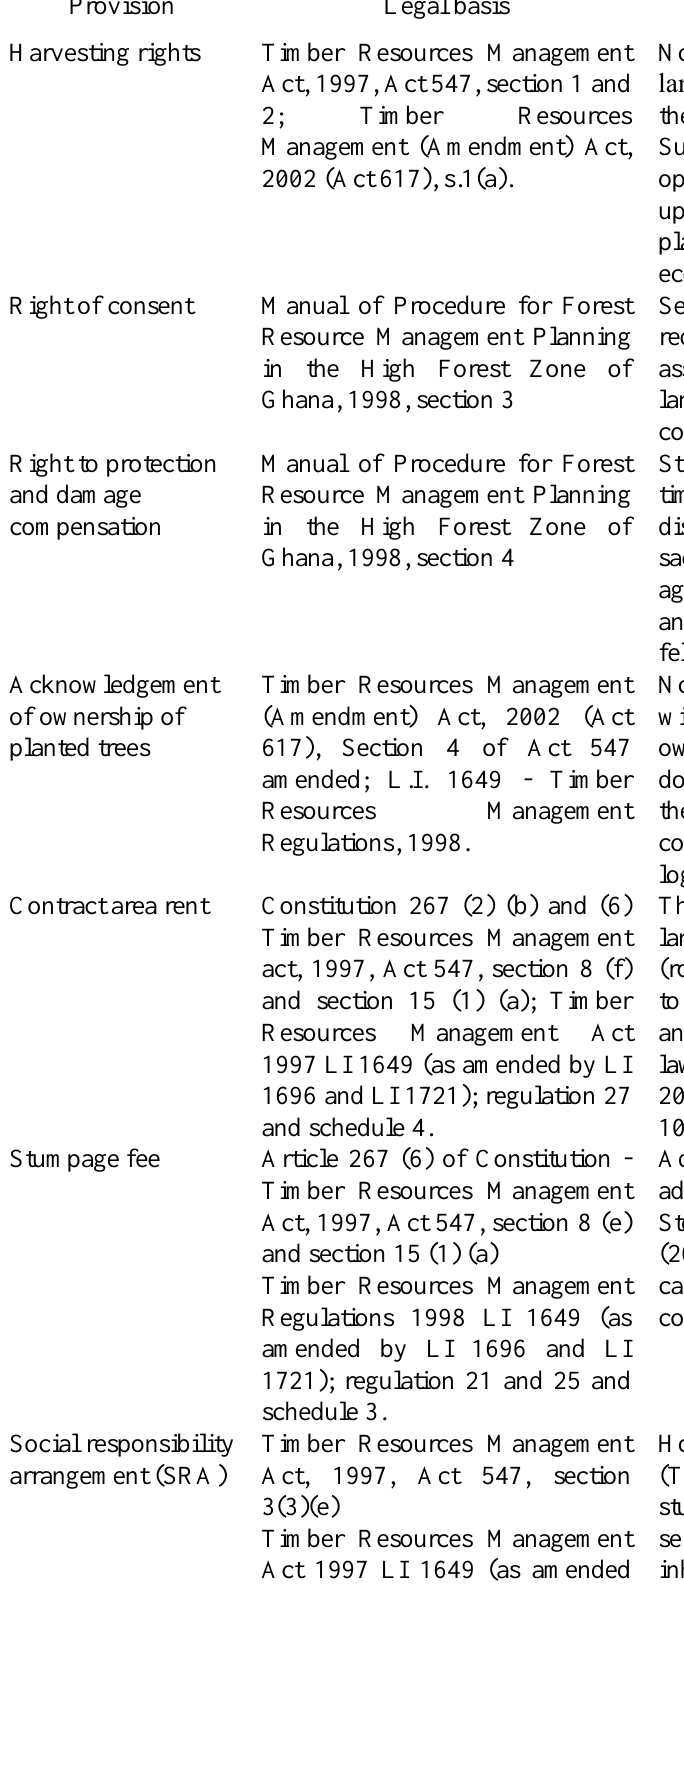
Table 1. Benefit-sharing arrangements for off-reserve timber trees in